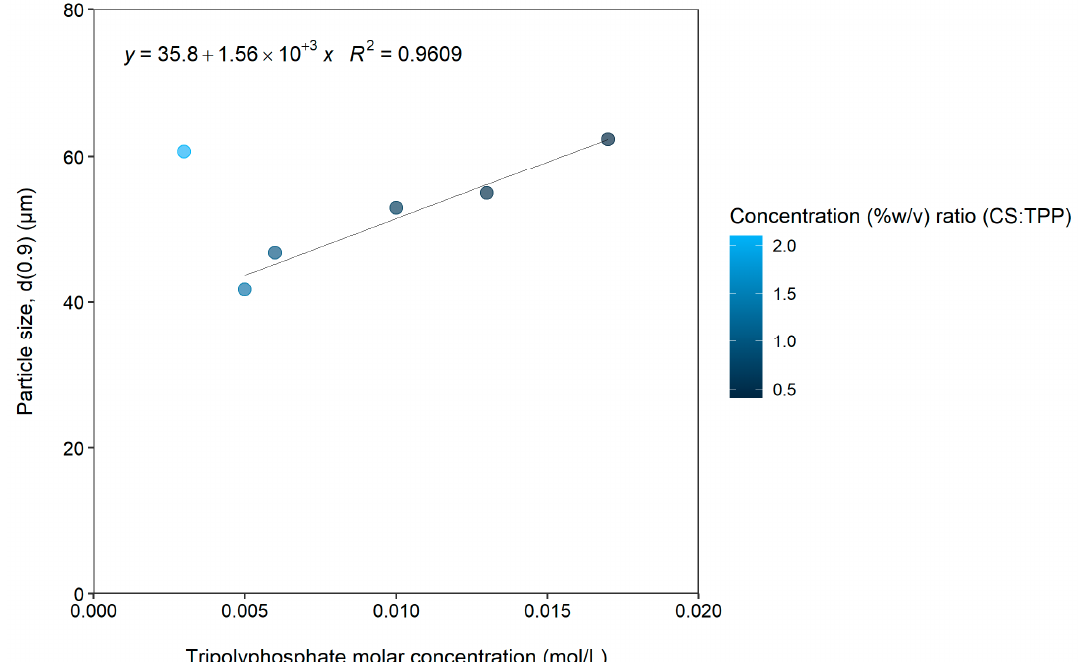
Figure 1. The particle size (d(0.9)) values plotted as a function of tripolyphosphate molar concentra- tion at a fixed chitosan concentration of 0.005 mol/L. The chitosan (CS):tripolyphosphate (TPP) con- centration (% w / v ) ratios are also indicated by color intensity of the markers.